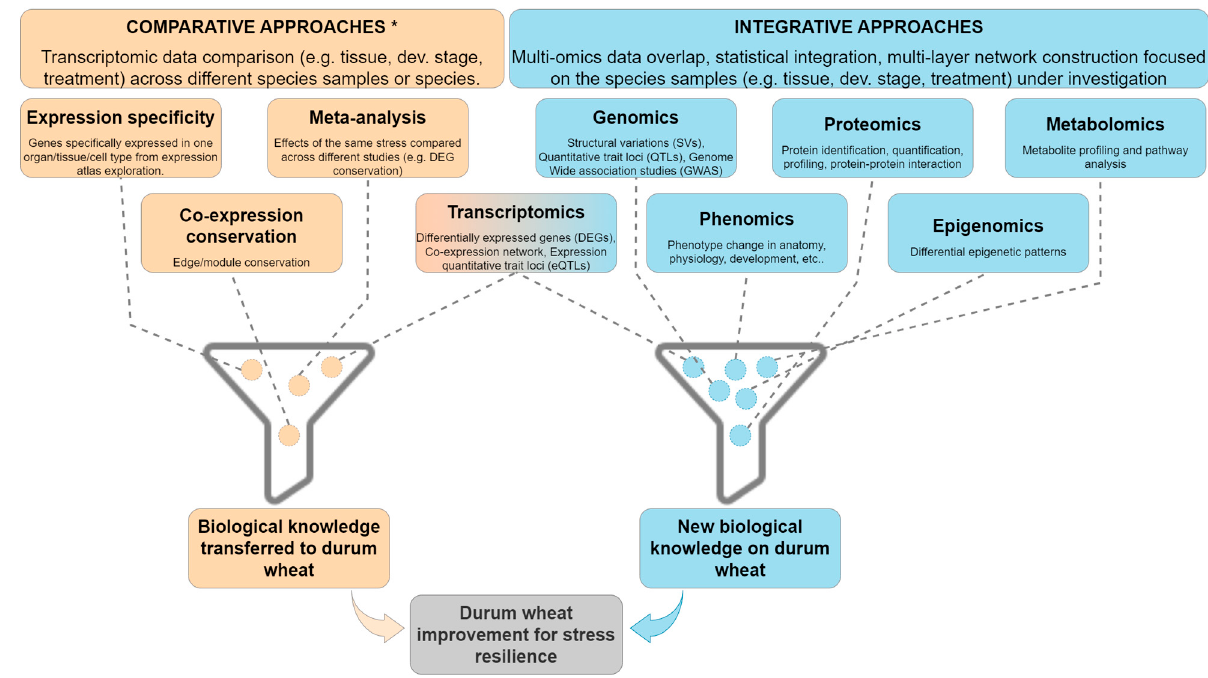
Figure 2. Comparative and integrative approaches for durum wheat transcriptomic data integration and exploitation. *: For these approaches orthology information is needed. Dev: developmental.